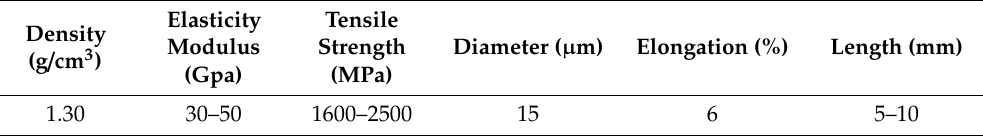
Table 4. Physical properties of the PVA fiber.